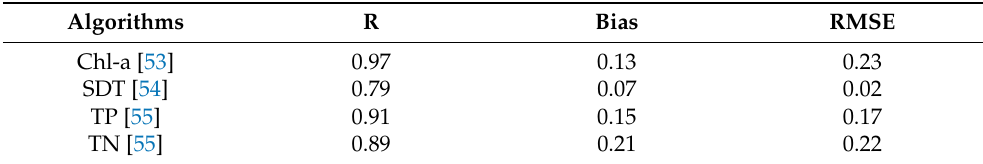
Table 3. Statistical comparisons of used algorithm in this study with other regional/world-wide